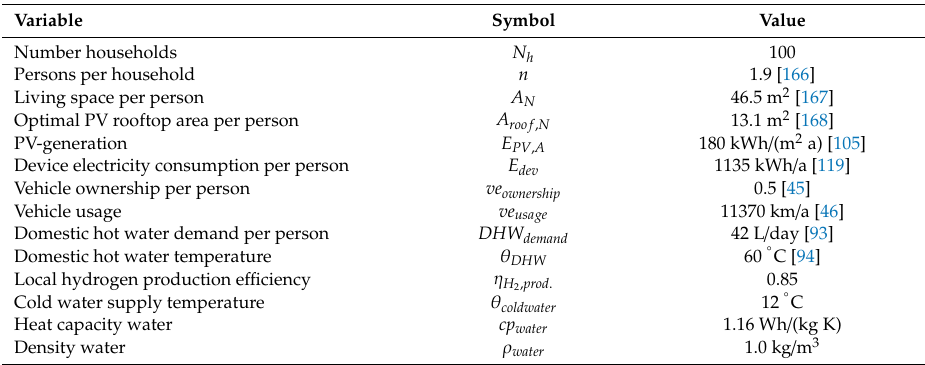
Table 2. Parameters for calculation.